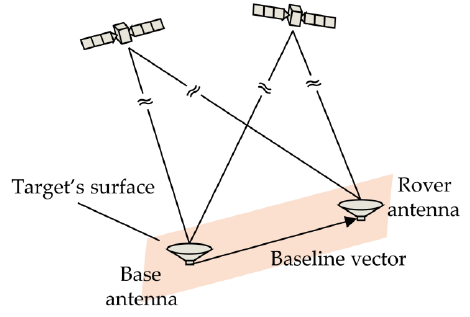
Figure 1. Basic principle of attitude determination with GNSS.